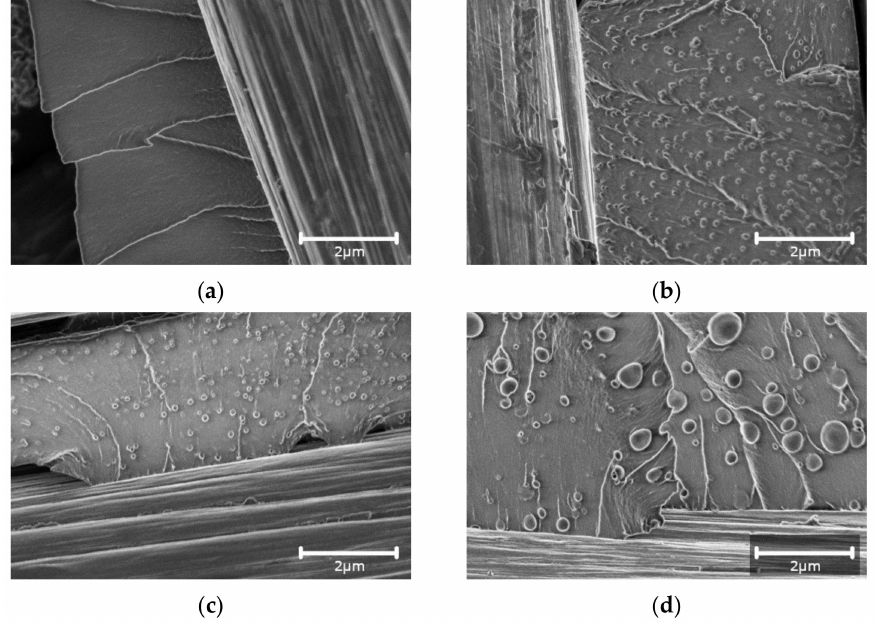
Figure 1. SEM images of fracture surface for the CFRP impregnated with the neat epoxy ( a ) and epoxy/CSR particles (4 wt.%) for the additives: ACE MX-125 ( b ), ACE MX-156 ( c ), and ACE MX-960 ( d ) (scale—2 µ m, magnification— ×